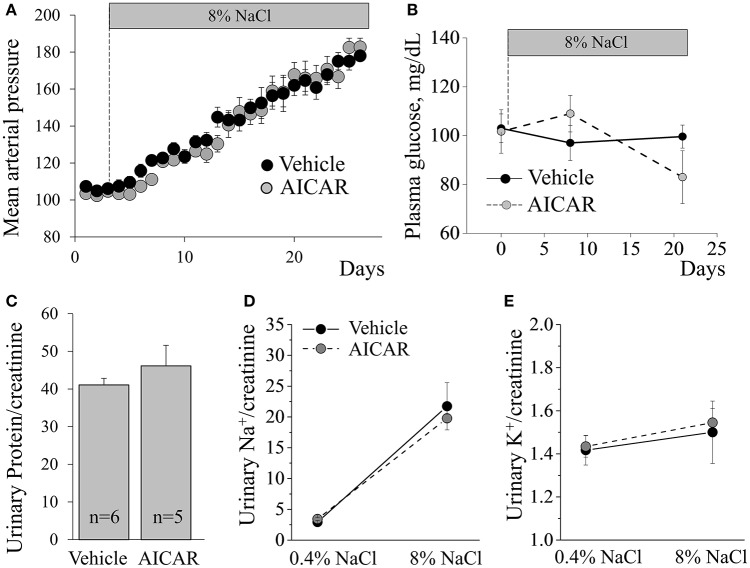
AICAR does not alter development of SS hypertension. (A) Blood pressure recordings collected from vehicle- or AICAR-treated Dahl SS rats during development of hypertension on an 8% NaCl diet (n = 6 and 5, respectively). Effect of AICAR treatment on the blood glucose level (B), proteinuria (C), sodium (D), and potassium (E) excretion in Dahl SS rats fed an 8% diet. No significant differences between vehicle and AICAR-treated rats were found on any of the parameters tested.